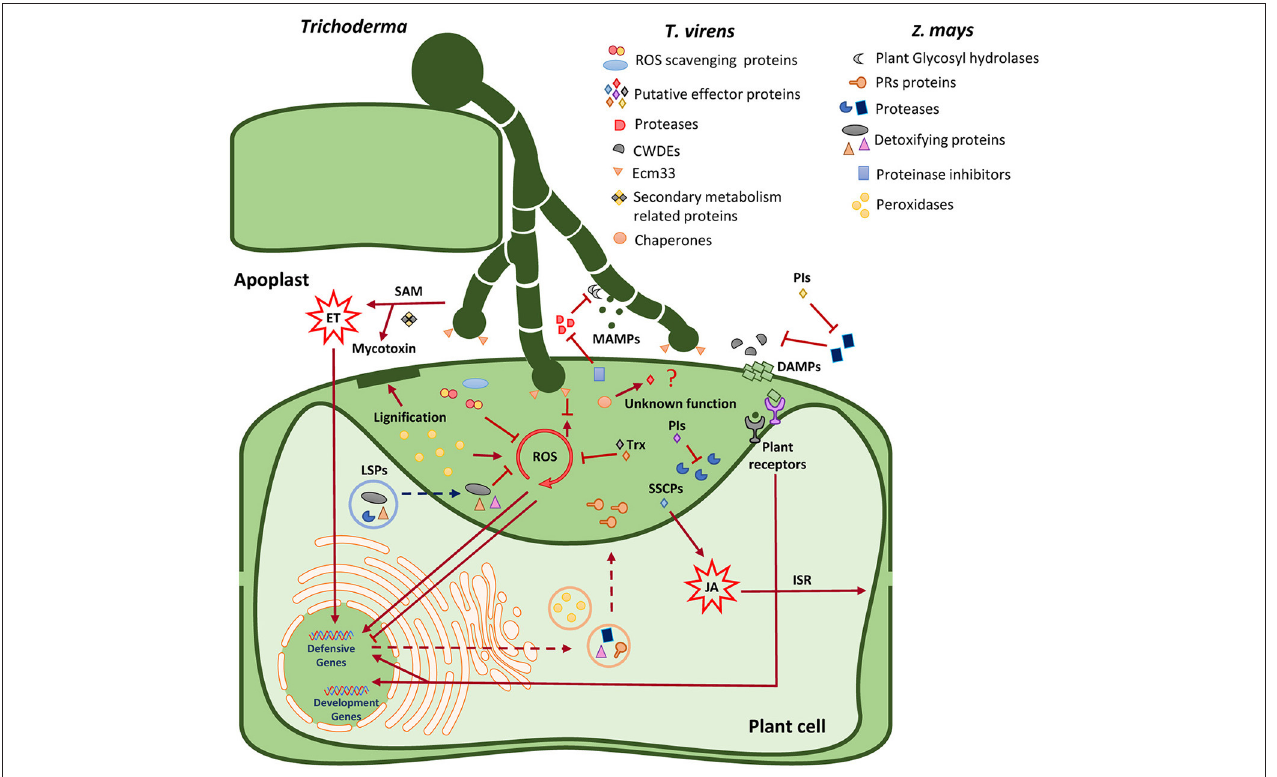
FIGURE 6 | Model of apoplastic proteins identified in the T. virens- maize interaction. Location and putative function of apoplastic proteins secreted by T. virens and maize. ET, ethylene; JA, jasmonic acid; ISR, induced systemic resistance; ROS, reactive oxygen species; MAMPs, microbial-associated molecular patterns; DAMPS, damage-associated molecular patterns; CWDEs, Cell wall degradative enzymes; PRs, pathogenesis-related proteins; PIs, proteinase inhibitors; Trx, thioredoxin; LSPs, leaderless secretory proteins; SAM, S-adenosyl-l-methionine; SSCPs, small secreted cysteine-rich proteins.